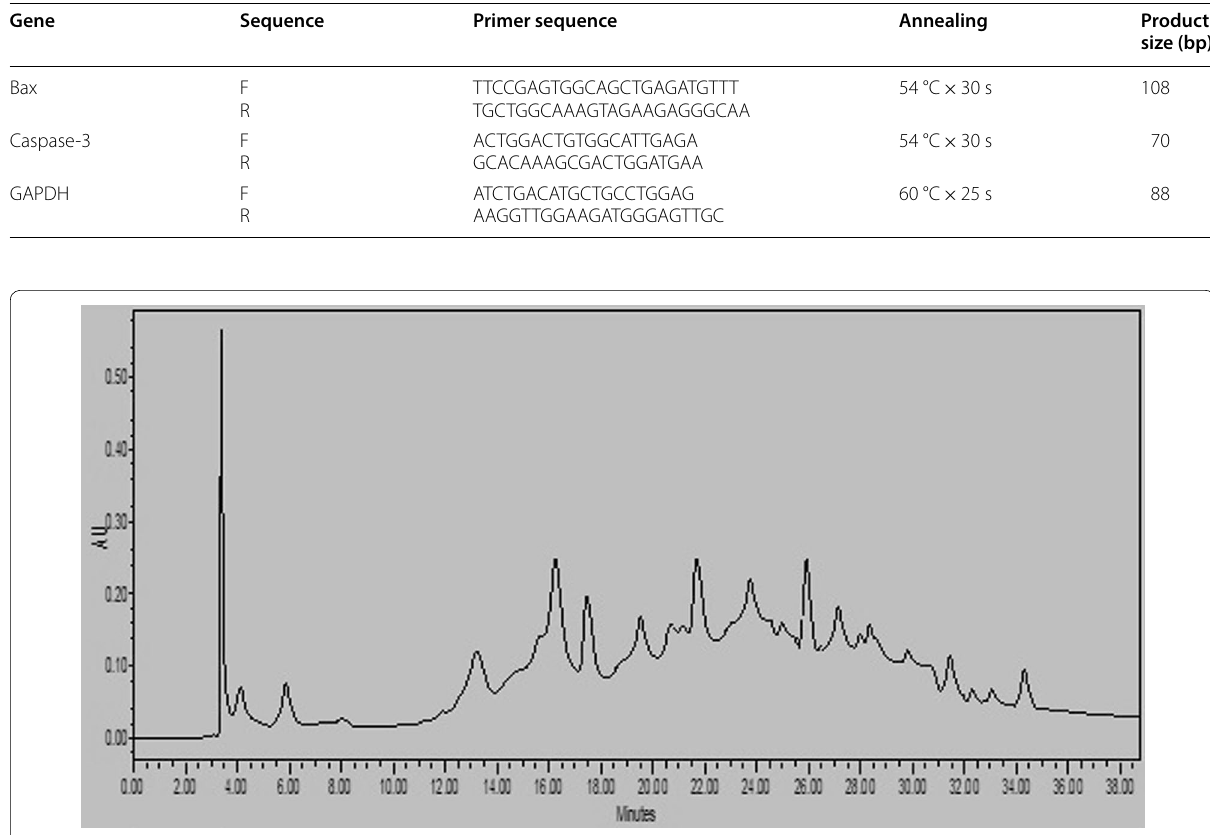
Fig. 1 HPLC chromatogram of Linum usitatissimum Extract. Identification and quantification of compounds was done by comparing retention time and spectra of the peaks in the extract against that of the standard